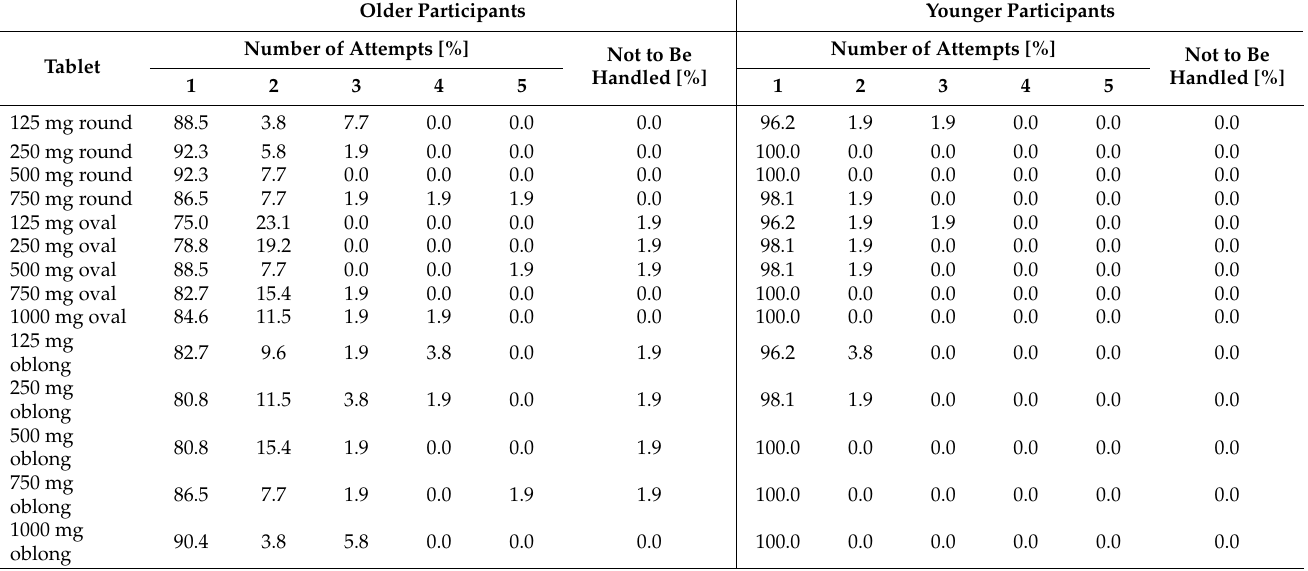
Table 5. Number of attempts needed by the participants to pick up the different tablets from a table and to put them into a box 30 cm above the table surface. Data are shown separately for older participants ( left ) and younger participants ( right